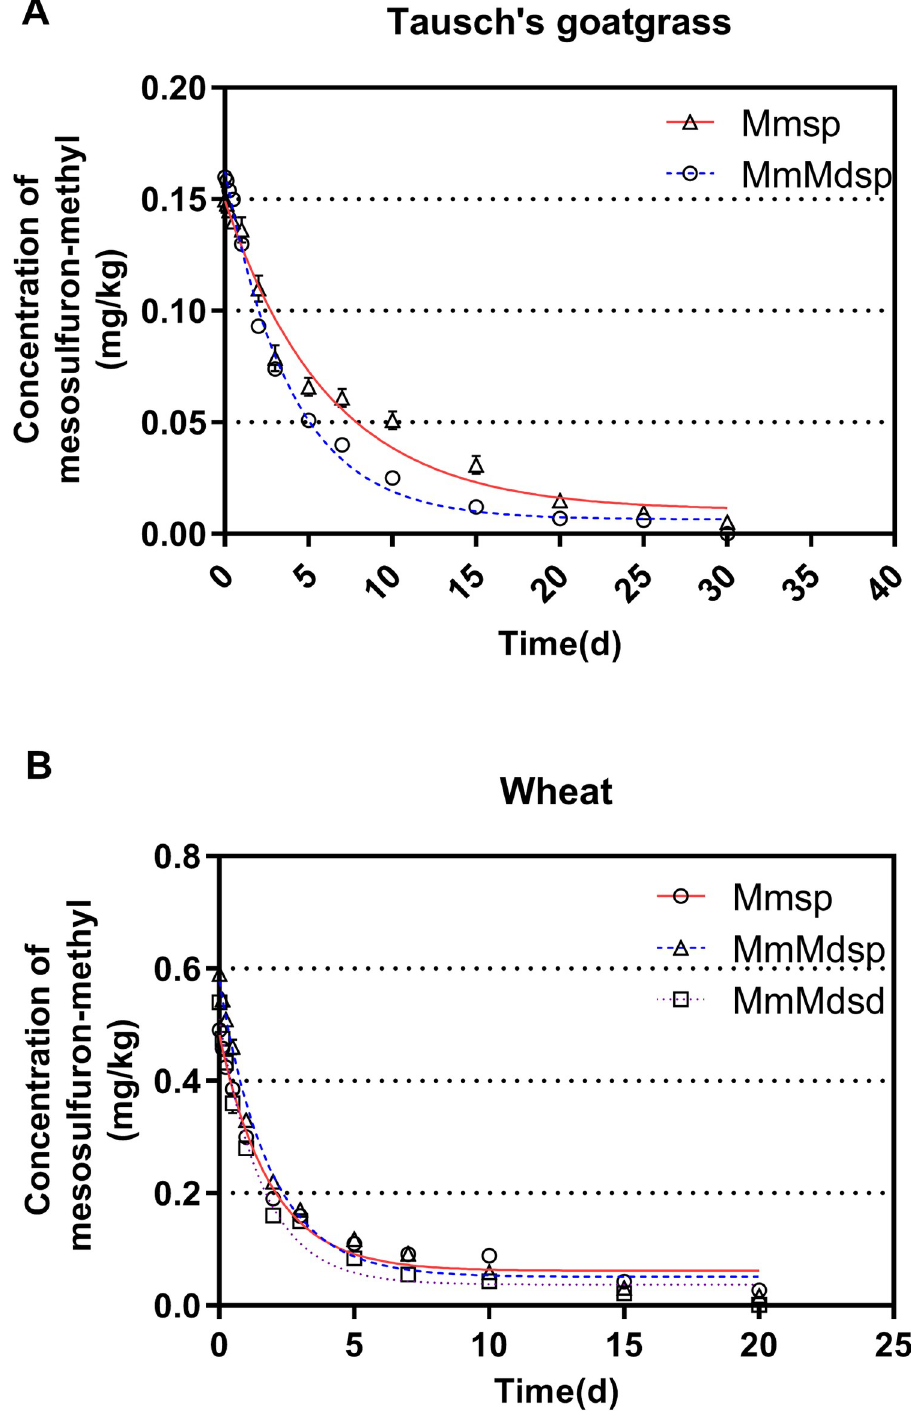
Fig 1. Dissipation of mesosulfuron-methyl in Tausch’s goatgrass (A) and wheat (B) according to the exponential decay equation. The line represents the first-order regression equation. Data points are the means of three replications, with bars indicating the standard error of the mean. Mmsp: Plants treated with mesosulfuron-methyl by spraying, MmMdsp: Plants treated with mesosulfuron-methyl and mefenpyr-diethyl by spraying, MmMdsd: Plants treated with Mesosulfuron-methyl by spaying and pretreated with mefenpyr-diethyl by seed dressing.